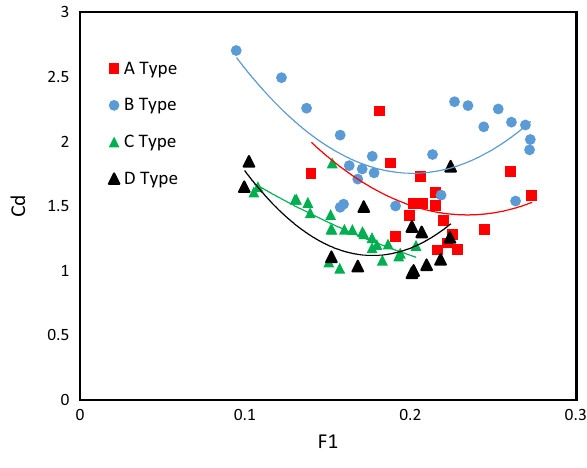
Fig. 10 Variations of discharge coefficient of piano key weir versus Froude number with L = 35 cm